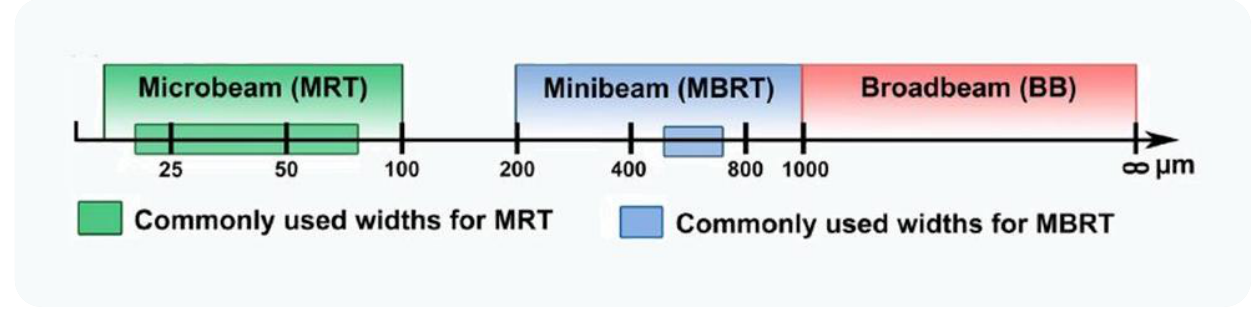
Figure 3. Schematic representation of commonly used widths for microbeam, minibeam, and broad- beam radiotherapy preclinical studies. Reproduced from Brönnimann et al., Nature Publishing Group, 2016 [115].